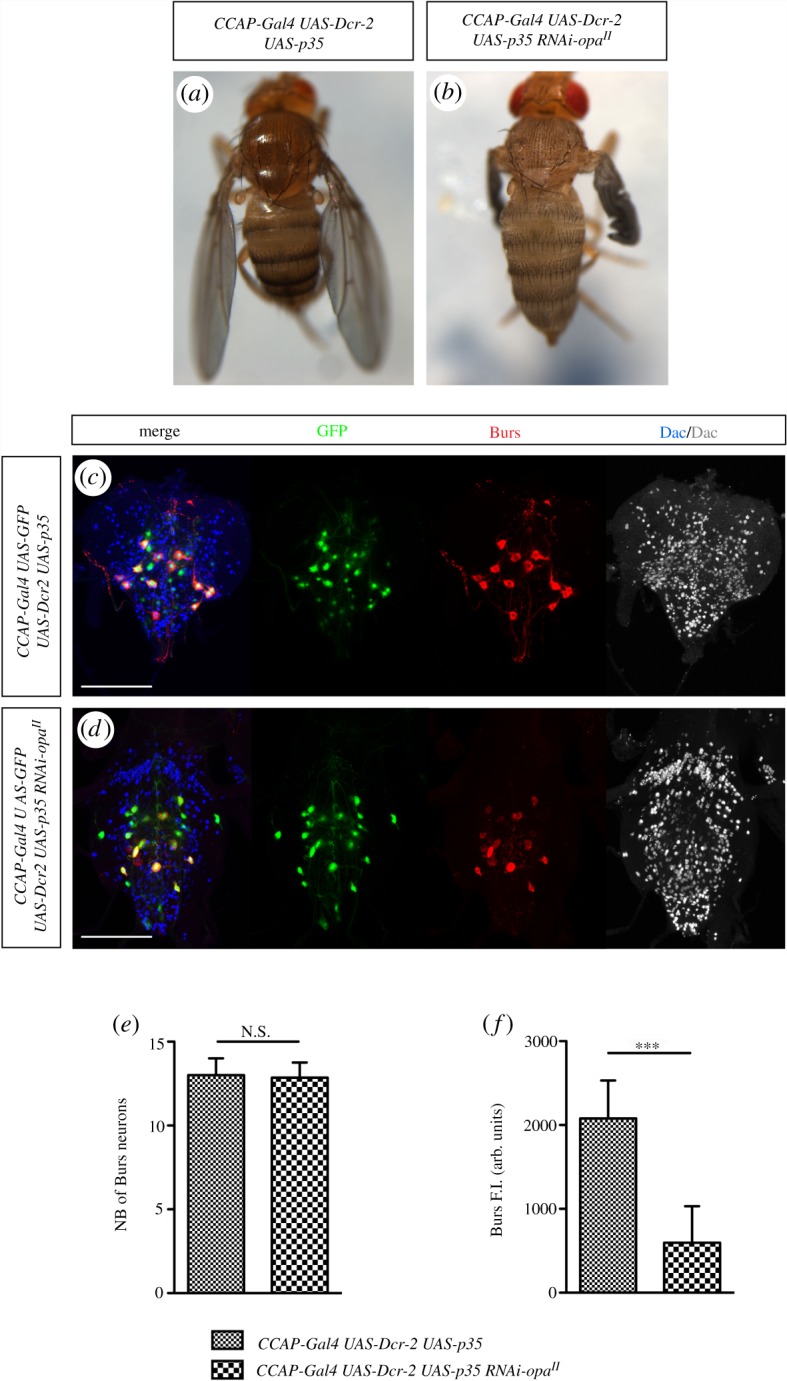
Opa regulates CCAP survival and Burs expression. (a) Ectopic expression of p35 to block cell death together with Dcr-2 does not affect normal post-ecdysial maturation. (b) Simultaneous ectopic expression of UAS-p35, UAS-Dcr-2 and UAS-RNAi-opaII in the CCAP neurons does not rescue the post-eclosion phenotype induced by the lack of opa shown in figure 3b (100%, n = 60). The pictures of adult flies shown in (a,b) have been taken 3 h after eclosion. (c) VNC of control flies that express simultaneously UAS-Dcr-2 and UAS-p35 in the CCAP neurons. Inhibition of CCAP cell death has no effect on either CCAP cell number or CCAP-Gal4 or Burs expression. (d) VNC of flies that express UAS-p35, UAS-Dcr-2 and UAS-RNAi-opaII ectopically in the CCAP cells of the VNC show similar CCAP cell number than control flies (c). However, the expression of Burs significantly decreased compared with control. VNC in (c,d) have been dissected from adult flies that were 0–1 h old. Scale bar, 100 µm. (e,f) Statistical analysis of cells expressing Burs in CCAP-Gal4, UAS-Dcr-2 and UAS-p35 flies (e), n = 7; mean of number of neurons expressing Burs per fly VNC = 13,0 (s.e.m. ± 0,4) and for CCAP-Gal4 UAS-Dcr-2 UAS-p35 and UAS-RNAi-opaII flies (e), n = 7; mean of number of neurons expressing Burs in each VNC = 12,9 (s.e.m. ± 0,3). No significant difference (N. S.) mean p-values ≥= 0.05. (f) Statistical analysis of cells expressing Burs in CCAP-Gal4, UAS-Dcr-2, UAS-p35 flies, n = 88 cells; mean of Burs fluorescent intensity (F.I.) is in arbitrary units (a.u.) per cell = 2079 (s.e.m. ± 48). In CCAP-Gal4 UAS-Dcr-2, UAS-p35, UAS-RNAi-opaII flies, n = 85 cells; mean of Burs F.I. in a.u. = 596 (s.e.m. ± 47) per cell. ****p-value < 0.0001.